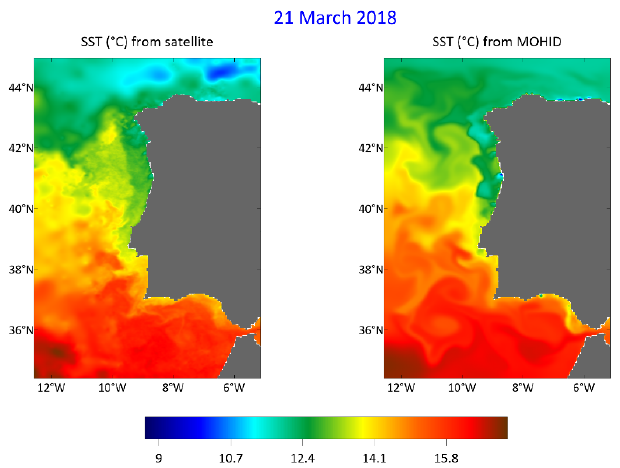
Figure 10. Sea surface temperature for 21 March 2018 from the Multi-scale Ultra-high Resolution (MUR; Left) and PCOMS with LAMBDA Complete Observations boundary conditions. Basic com- parison statistics: Average PCOMS SST: 14.287; Average MUR SST: 13.992; Coef. Correlation: 0.929; Bias: 0.295 and RMSE: 0.537.